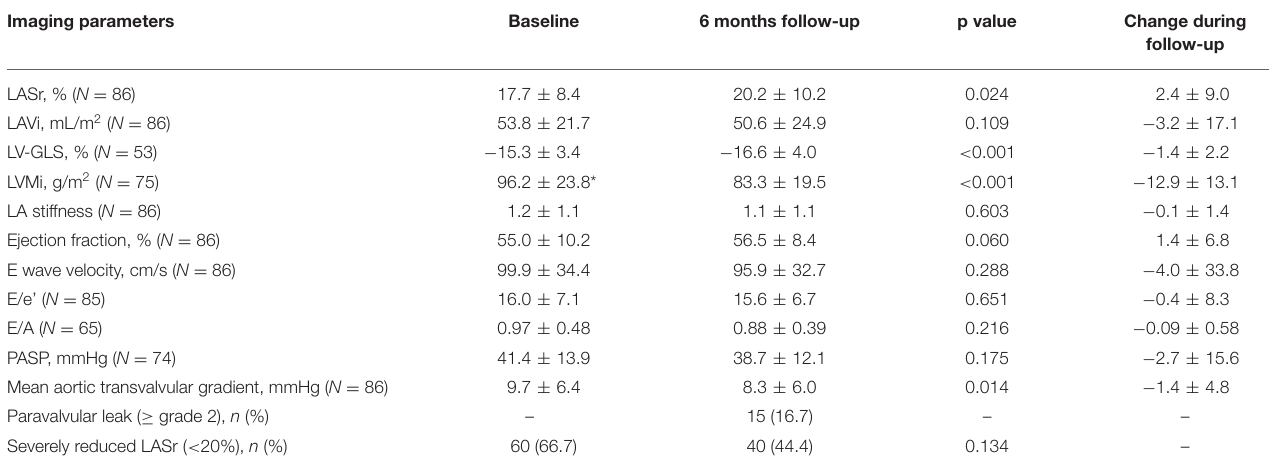
TABLE 2 | Periprocedural data and change in systolic and diastolic